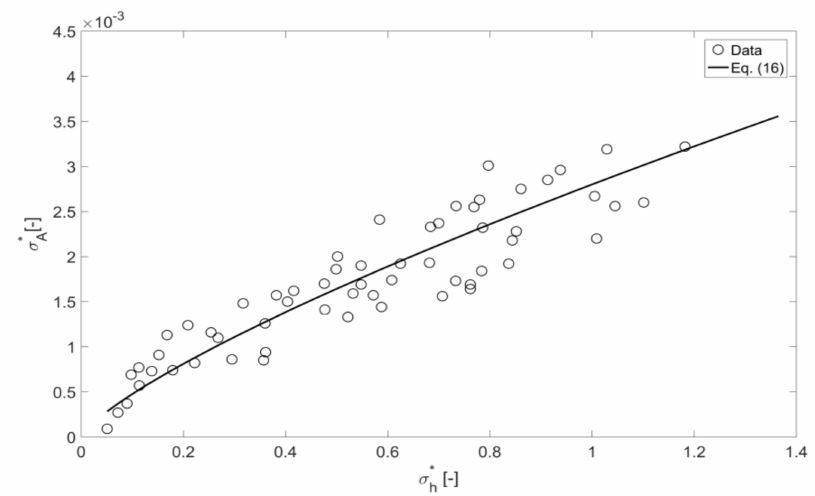
Figure 12. Normalized standard deviation in the continuous sine wave envelope as a function of the normalized mean free surface roughness height for all conditions, with R 2 = 0.85, Equation